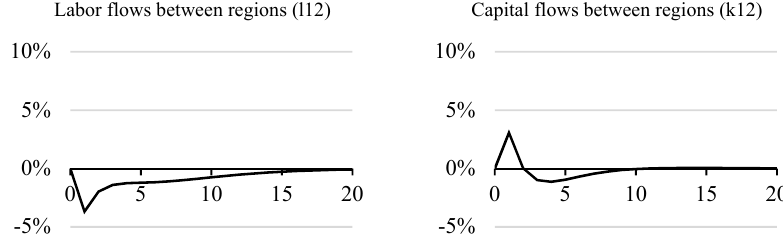
Figure 6. Net flows of factors of production from the first to the second region. Exports of goods from the first region to the second are declining against the back- ground of a decrease in consumer activity in the latter, which contributes to the decline in the first region. Conversely, the growth of consumer spending in the first region stimulates the import of goods from the second region and economic activity within it (Figure 7).